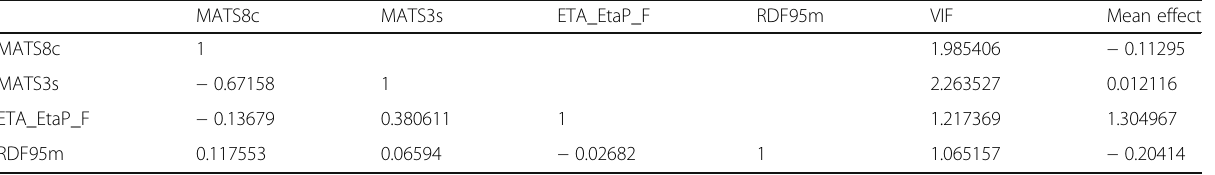
Table 7 Correlation, VIF, and mean effect of molecular